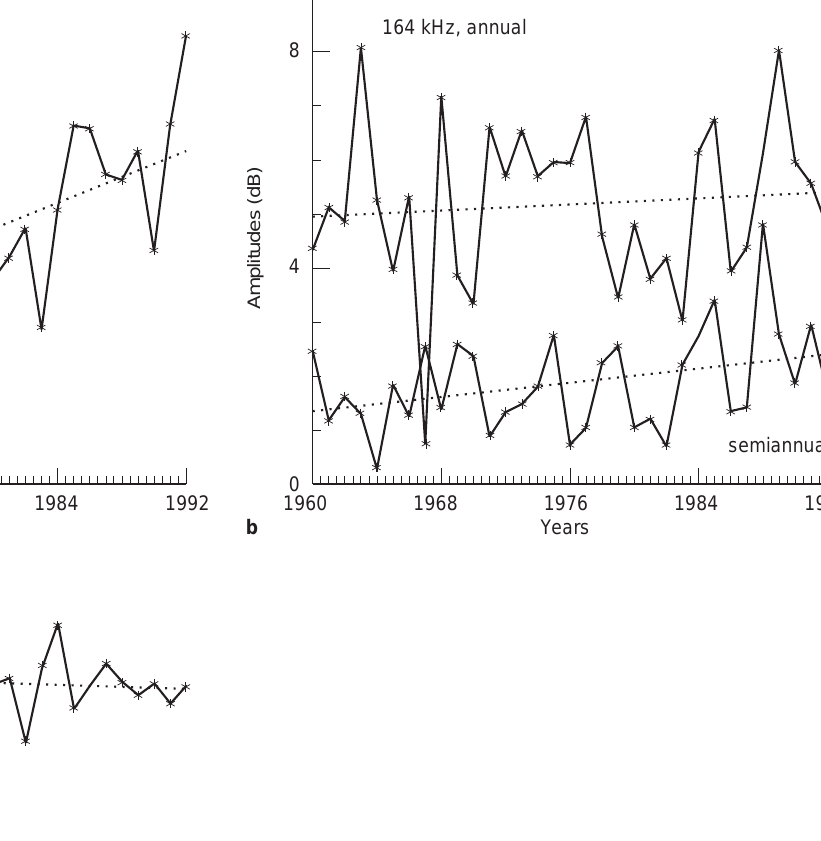
Fig. 1. a Trend in the yearly constant (slope = +0.217 dB/y) at 164 kHz, 1960–1992. b Trends in the amplitudes of the AW ( top curve ; k = +0.015 dB/y) and SAW ( bottom curve ; k = +0.033 dB/y) in absorption at 164 kHz, 1960–1992; k – slopes of curves. c Trends in the phases of the AW ( top curve ; k = ) 0.245 day/y) and SAW ( bottom curve ; k = ) 0.475 dB/y) in absorption at 164 kHz, 1960– 1992; k – slopes